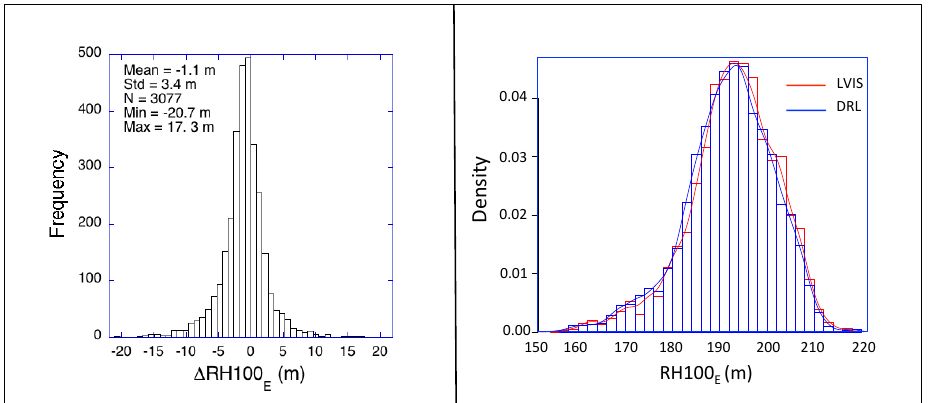
Fig. 4. Distribution of RH100E change between 1998 (LVIS) and 2009 (DRL) (left), and distribution of RH100E for each date (right). Both histograms show that top canopy elevation decreased between the two surveys.